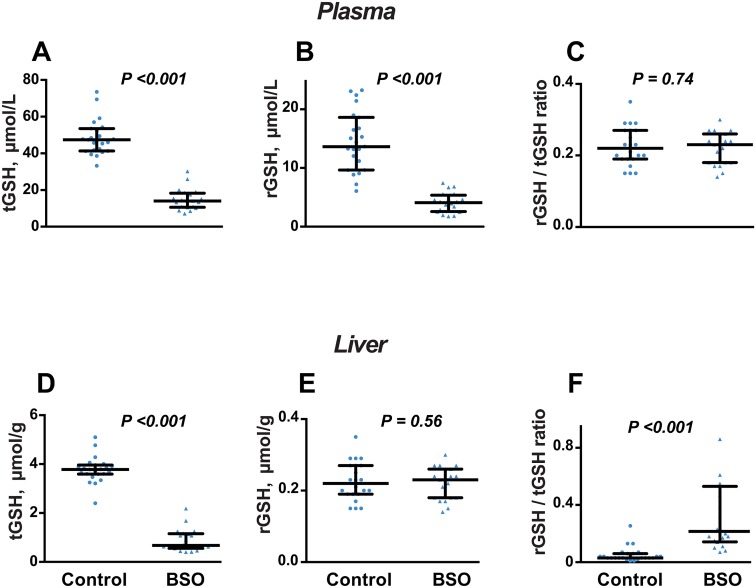
Effect of BSO on glutathione status after 8 weeks of treatment.A-C: Plasma total glutathione (tGSH), reduced glutathione (rGSH) and rGSH/tGSH ratio. D-F: Liver tGSH, rGSH and rGSH/tGSH ratio. Data is presented as median, 25th and 75th percentiles, with individual data plotted; N = 20 (BSO) and N = 23 (controls). Groups were compared by Mann-Whitney U test.